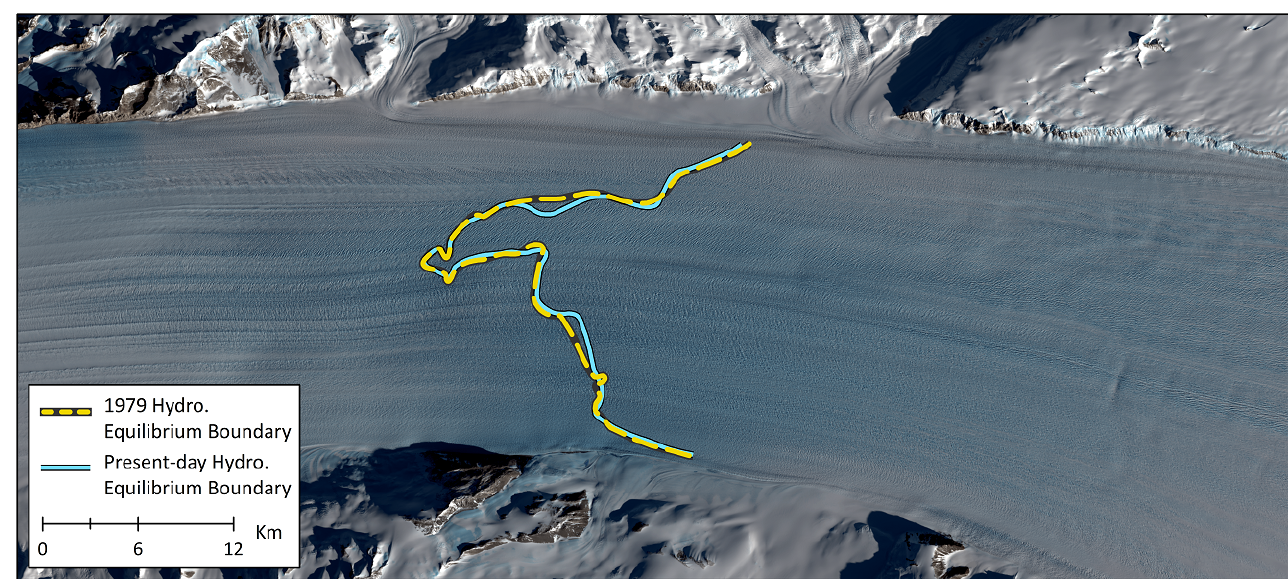
Figure 12. The hydrostatic equilibrium boundaries, calculated from historical and present-day elevation